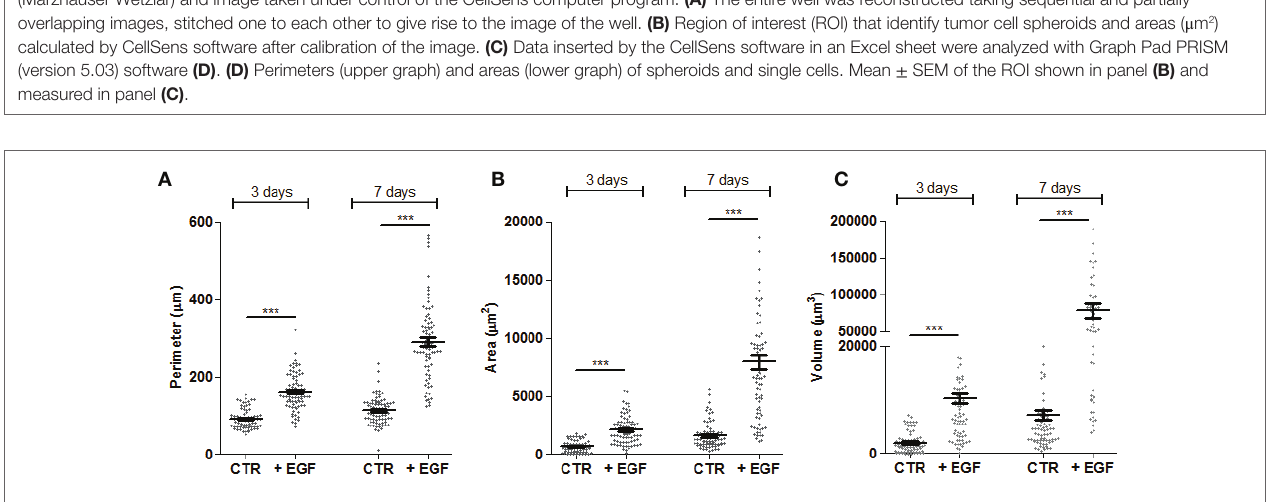
FIGURe 3 | Measurements of perimeter, area, and volume of CRC spheroids. The perimeter (A) , area (B) , and volume (C) of each spheroid was calculated as explained in Figure 2 and data were plotted with Graph Pad PRISM software. This example is referred to the HCT15 cell line cultured as indicated in Figure 1 .